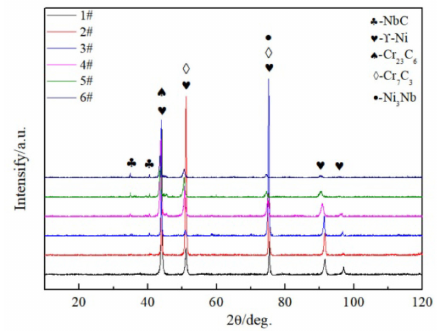
Figure 15. XRD spectra of different cladding